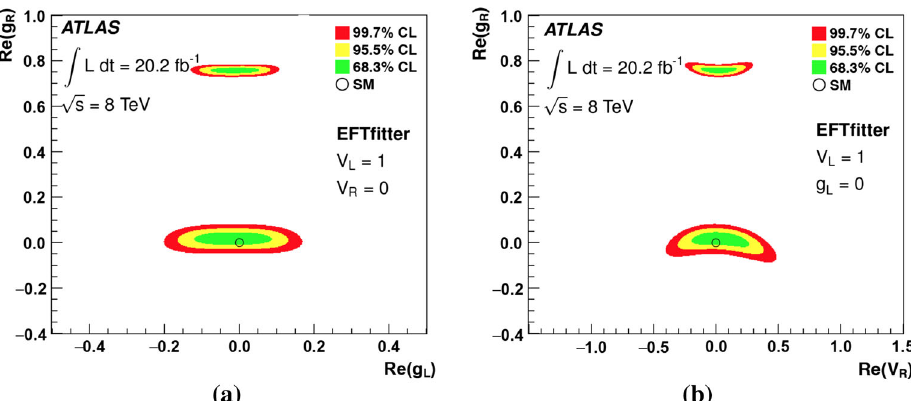
Fig. 6 a Limits on the anomalous left- and right-handed tensor cou- plings of the Wtb decay vertex as obtained from the measured W boson helicity fractions from the leptonic analyser. b Limits on the right-